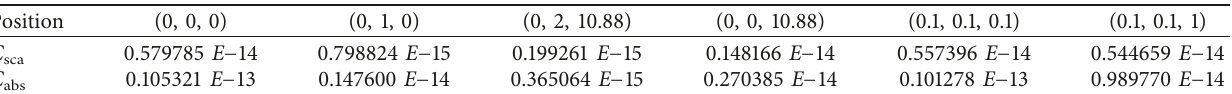
0.1, λ 0.5, m 1.33+0.1 i (cid:31) (cid:31) (cid:31)